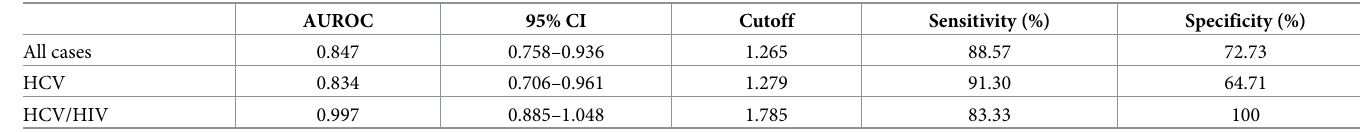
Table 3. Diagnostic accuracy of the proposed model to determine significant fibrosis.